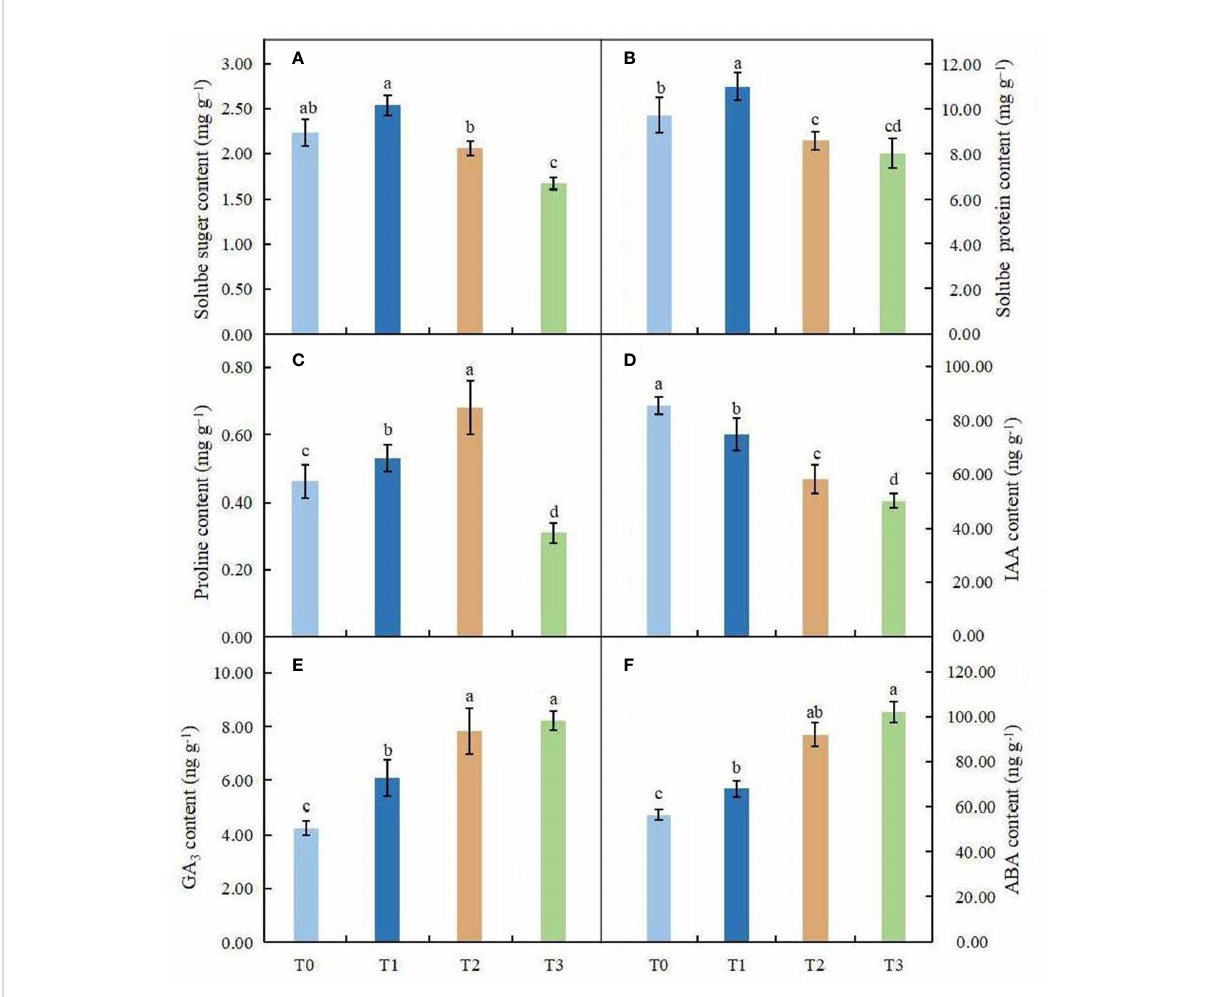
FIGURE 6 Effects of various light intensities on the soluble sugar content (A) , soluble protein content (B) , proline content (C) , IAA content (D) , GA 3 content (E) and ABA content (F) in leaves of C. betulus after 60 days. Different lowercase letters indicate signi fi cant differences between treatments ( P < 0.05), n =